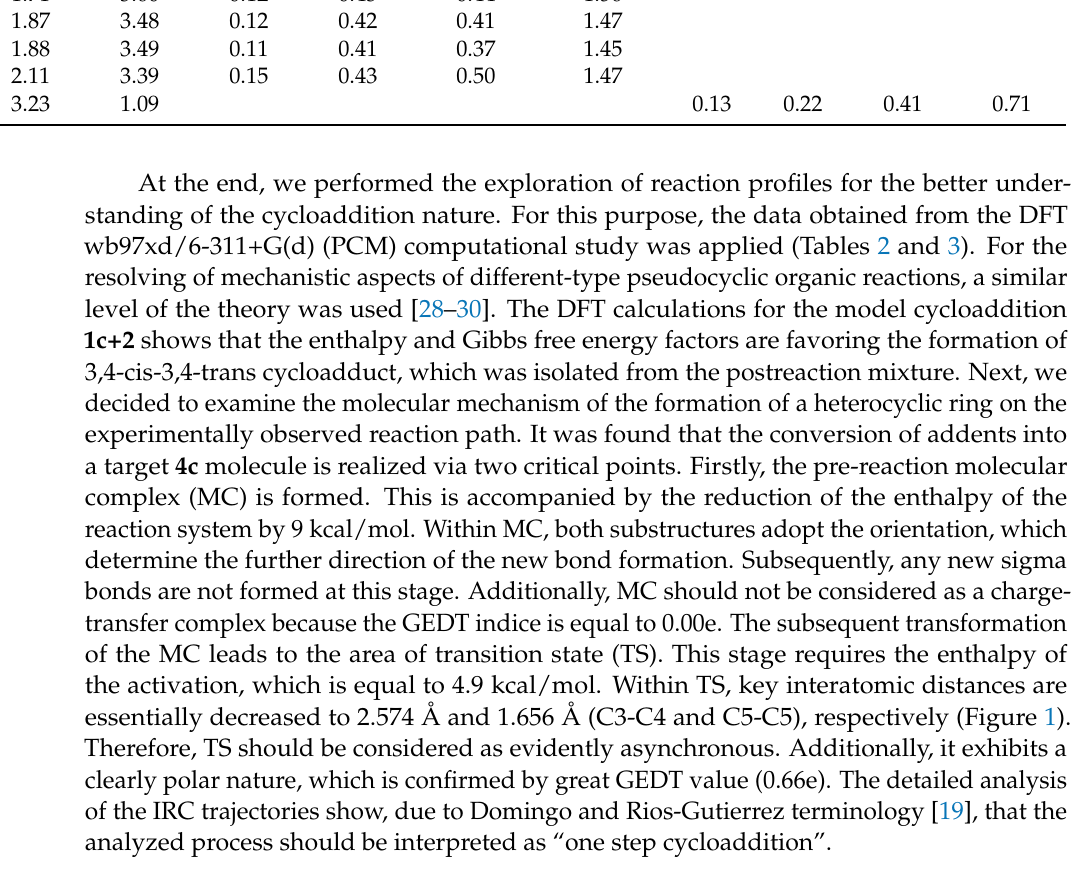
Table 2. Key parameters for critical structures for reaction 1c+2 → 3c in in light of the wb97xd/6- 311+G(d) (PCM)